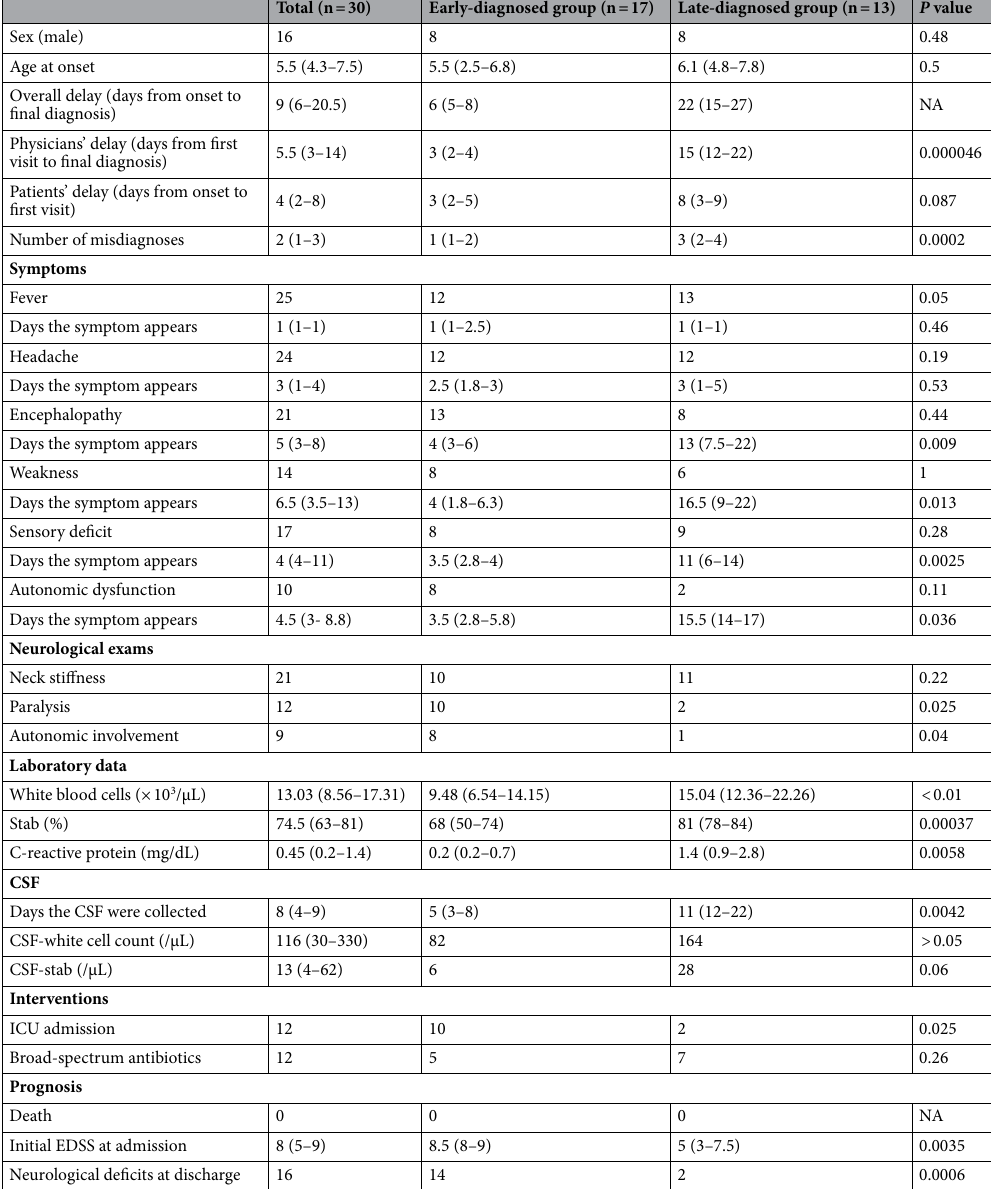
Table 1. Clinical parameters of the overall early-diagnosed and late-diagnosed groups. Numbers in parentheses denote interquartile ranges. CSF cerebrospinal fluids, ICU intensive care unit, EDSS expanded disability status score, NA not